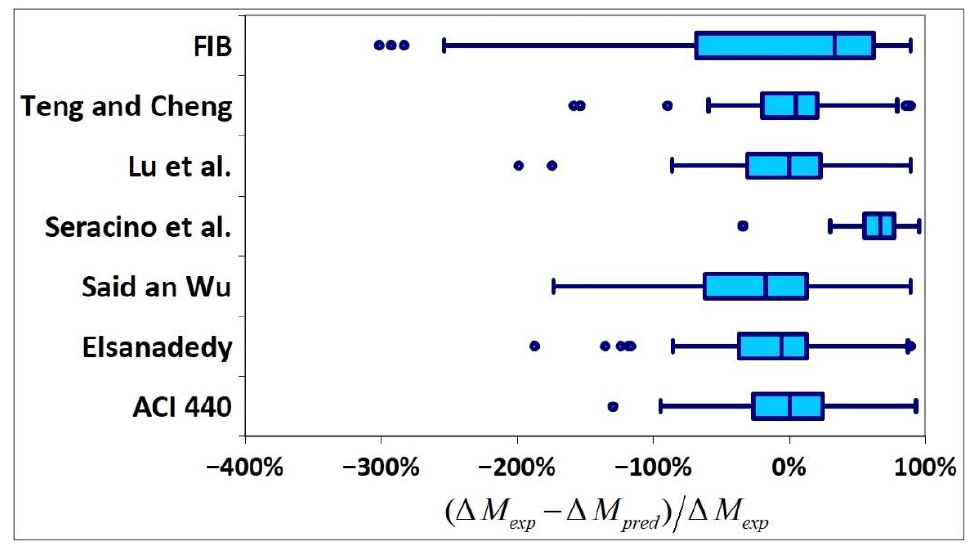
Figure 19. Comparison of predicted increase in flexural strength — box plots. Table 4. Comparison of deviation of predicted results.